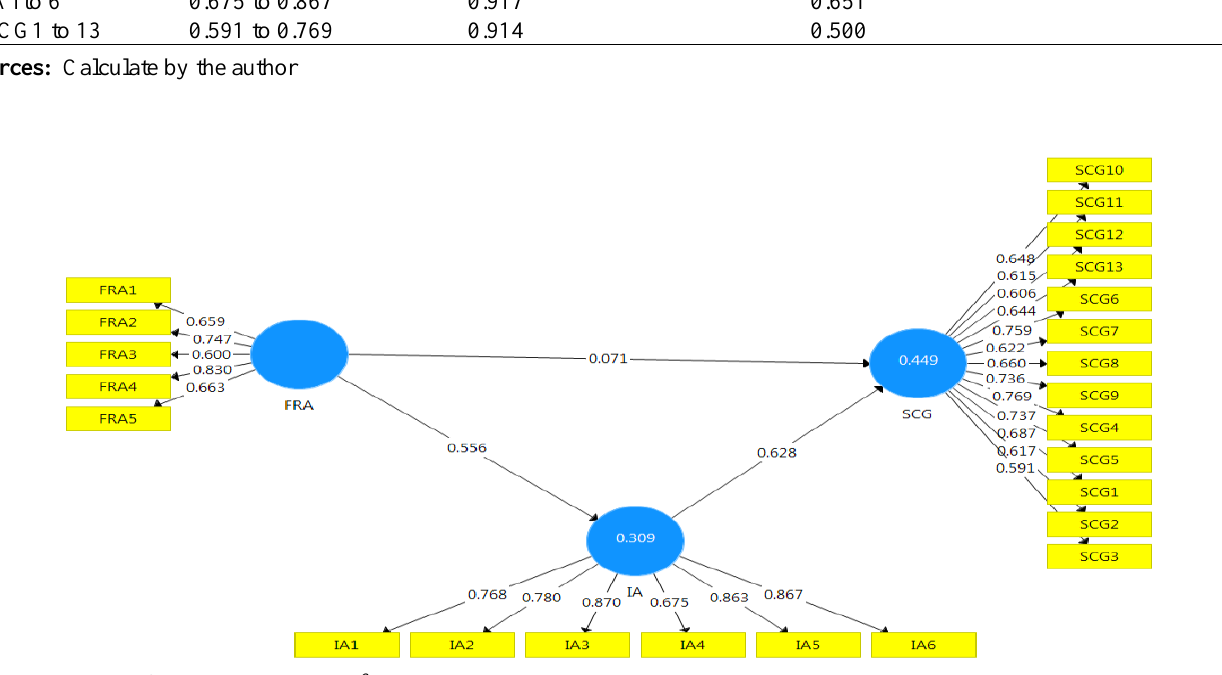
Figure 1: Value of Outer-loading and R